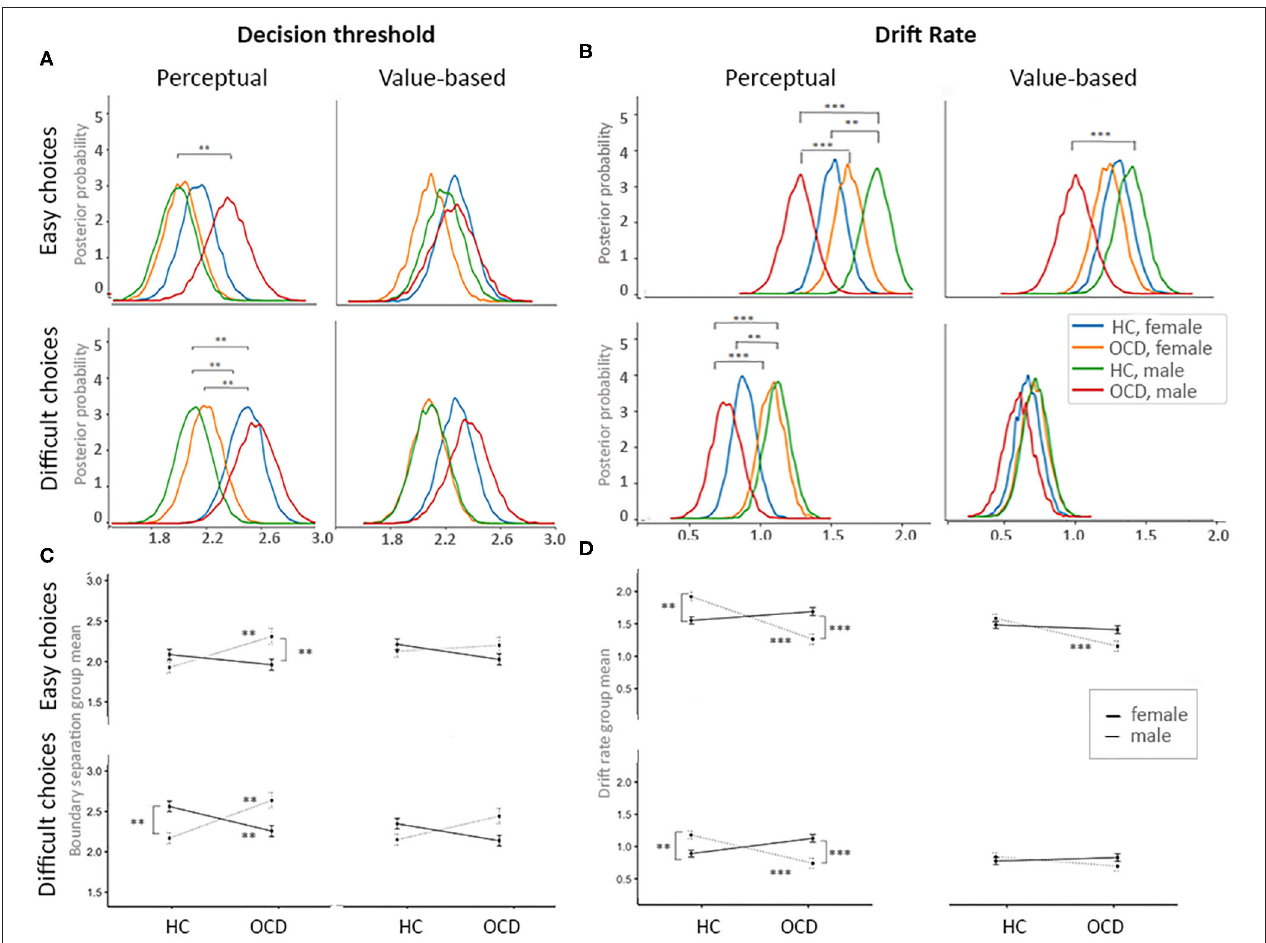
FIGURE 3 | Effects of OCD diagnosis and gender on the process of evidence accumulation. (A) Posterior probability plots for decision threshold for each of four decision contexts across four groups of interests. (B) Posterior probability plots for the drift rates for each of four decision contexts across four groups of interests. (C) Mean plots for the decision thresholds for each of four decision contexts across four groups of interests. (D) Mean plots for the drift rates for each of four decision contexts across four groups of interests. Significance levels: ** p = 0.05, *** p = 0.01.